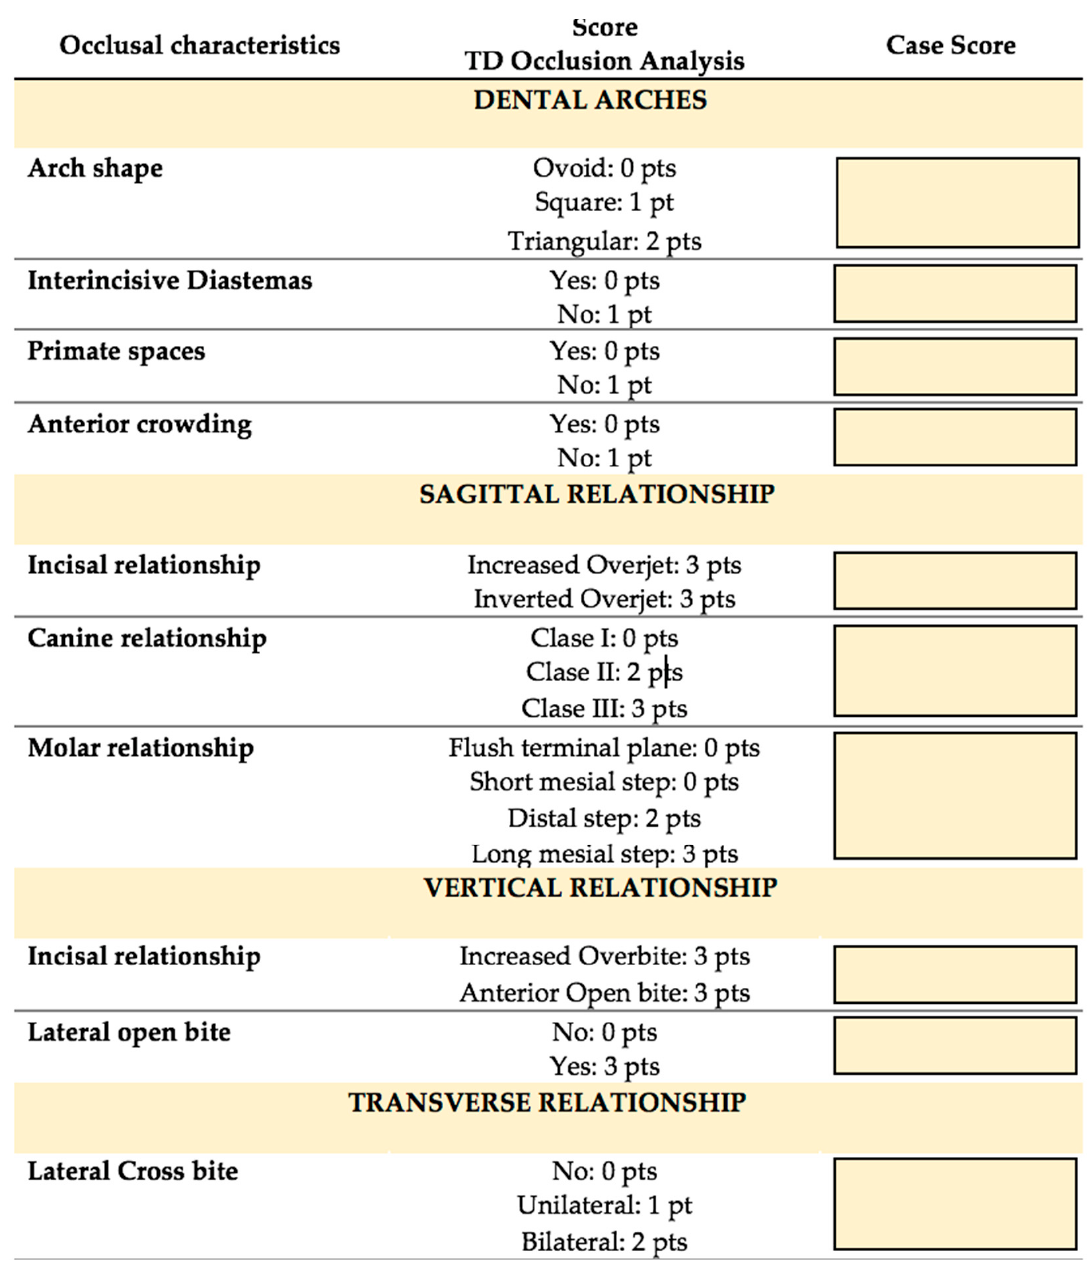
Figure 2. Primary Analysis Method.